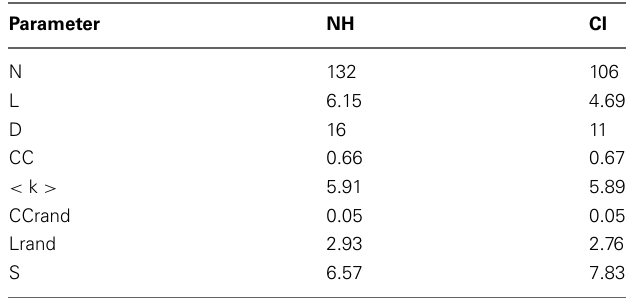
Table 1 | Summary of results of sample-matched correlation networks